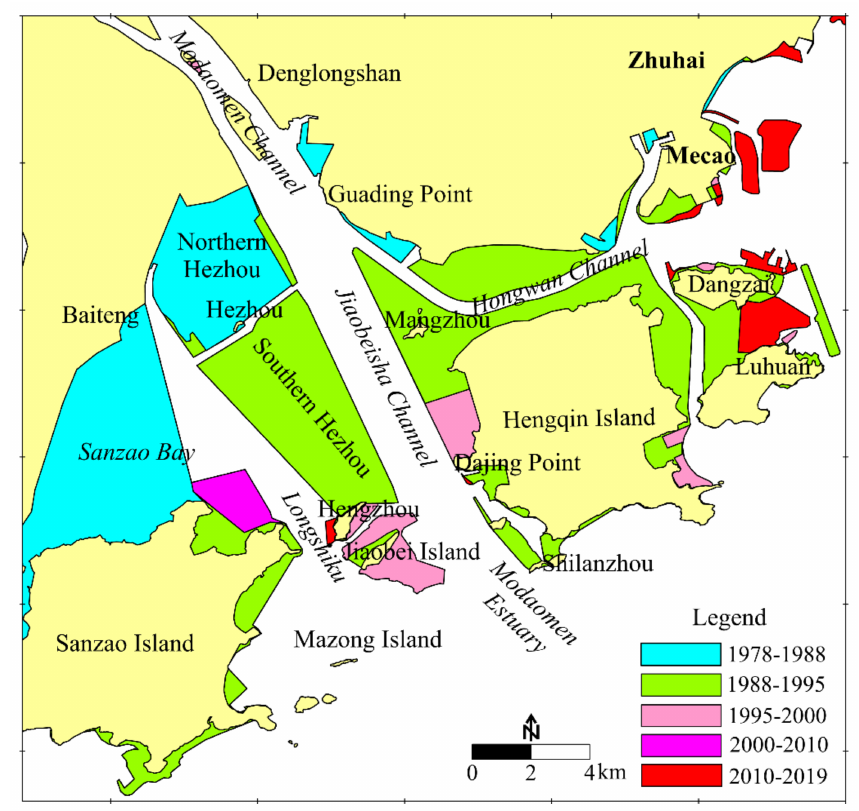
Figure 7. Planar map of the reclamation area during different